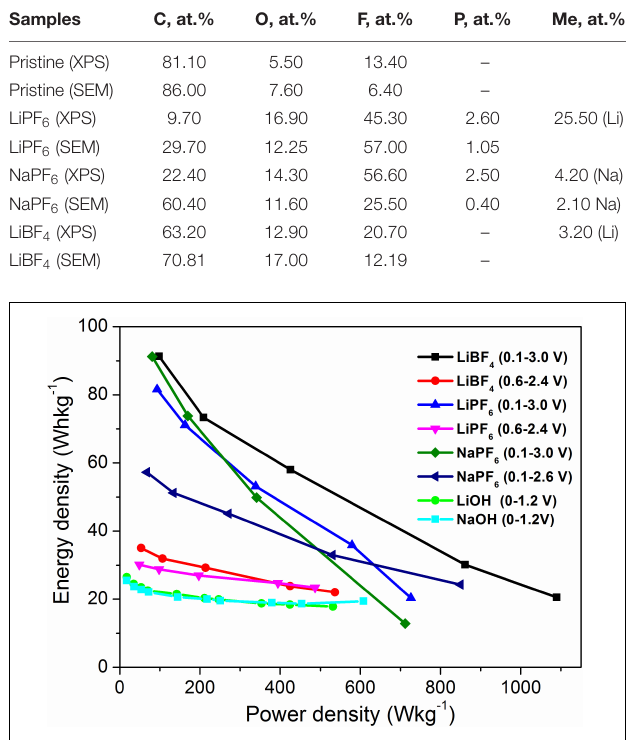
FIGURE 6 | Ragone plot of symmetric supercapacitors with YP-50F worked in organic and aqueous electrolytes.